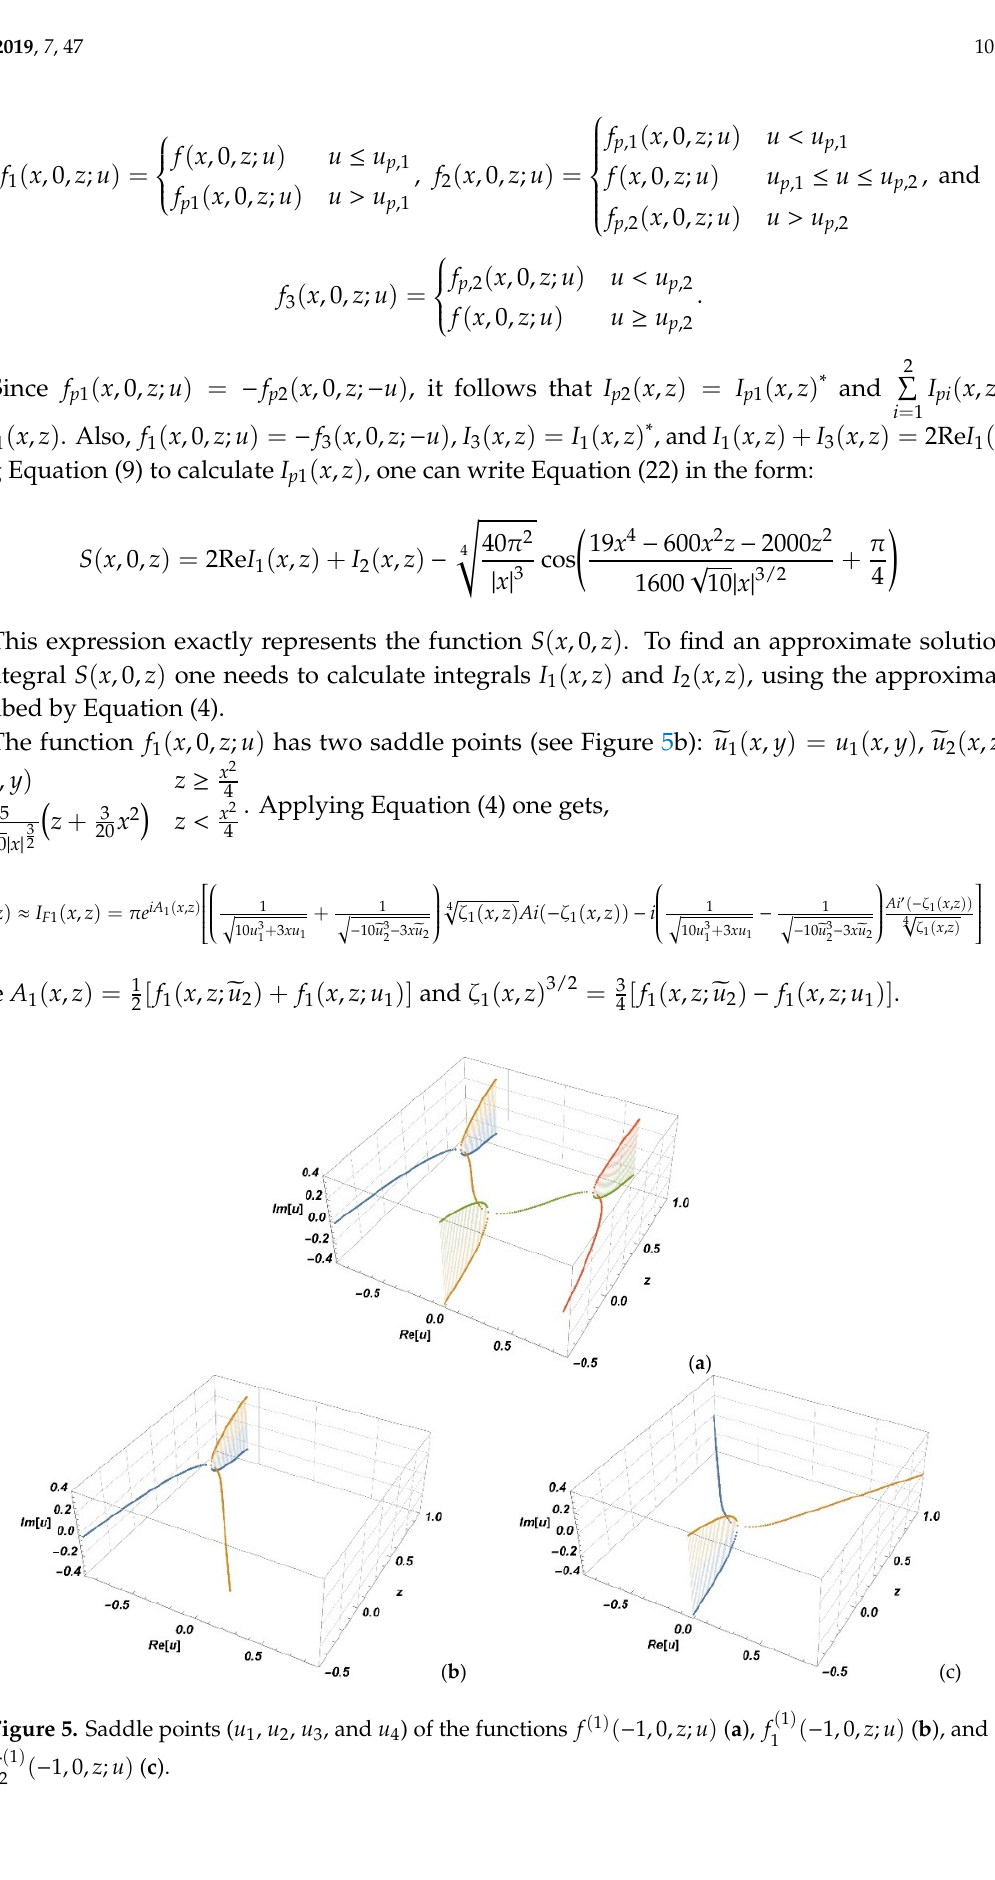
Figure 5. Saddle points ( 1 ( 1 ) ( − 1,0, z ; u ) ( c f 2